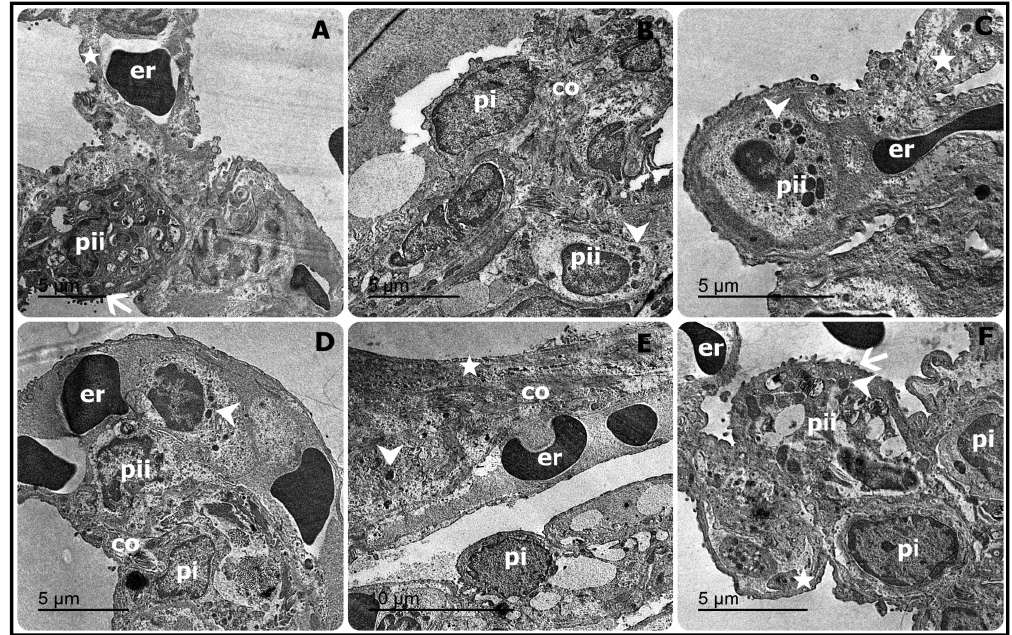
Figure 2. Representative electron micrograph of the lung sections showing apparently normal alveolar capillary with erythrocytes (er), blood–air barrier (star), pneumocytes type II (pii) with normal lamellar bodies and surfaces microvilli (arrow) in control rats ( A ). Pyknotic nuclei with chromatolysis, disappearance of cytoplasmic organelles, electron dense bodies (arrowhead) in pneumocyte type II (pii), few collagen deposits (co) in the proteinoid materials along with nearly normal pneumocyte type I (pi) were observed in CP-induced rats ( B ). Marked thickening of blood–air barrier due to proteinoid materials in the fused basal lamina (star), erythrocytes (er), disappearance of the cytoplasmic organelles, which were replaced by electron dense bodies (arrowhead) along with condensed chromatin in pneumocyte type II (pii), which suffered loss of the surfaces microvilli ( C ), marked necrotic pneumocytes types I and II (pi and pii) with lysis of cytoplasm with still few electron dense bodies (arrowhead) besides numerous erythrocytes (er) ( D ) were also observed in CP-intoxicated rats. Moreover, CP-induced rats exhibited thickening of the air–blood barrier (star), collagen deposits (co), extravasated erythrocytes (er), interstitial electron dense bodies (arrowhead) and degenerated pneumocyte type I (pi) ( E ). In contrast, apparently normal pneumocytes type I (pi), mild thickened blood–air barrier (star), restored pneumocyte type II components (pii), including empty lamellar bodies, and mitochondria (arrowhead) as well as surface microvilli (arrow) were reported in CP-induced rats treated with CUR ( F